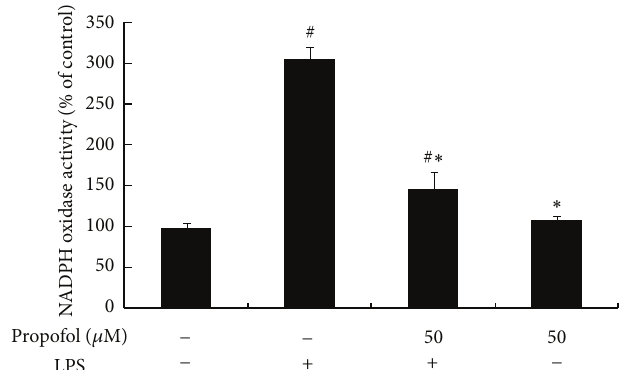
Figure 6: Effect of propofol pretreatment on NADPH oxidase activity. Cells were preincubated with dimethyl sulfoxide (DMSO) or propofol for 40min, followed by 6 h incubation with or without LPS. The activity of NADPH oxidase was measured with an oxidase activity assay kit. Each value represents the means ± SD for 𝑛 = 4 . # and ∗ indicate that a value significantly ( 𝑃 < 0.05 ) differs from without both propofol and LPS or only LPS treated groups,